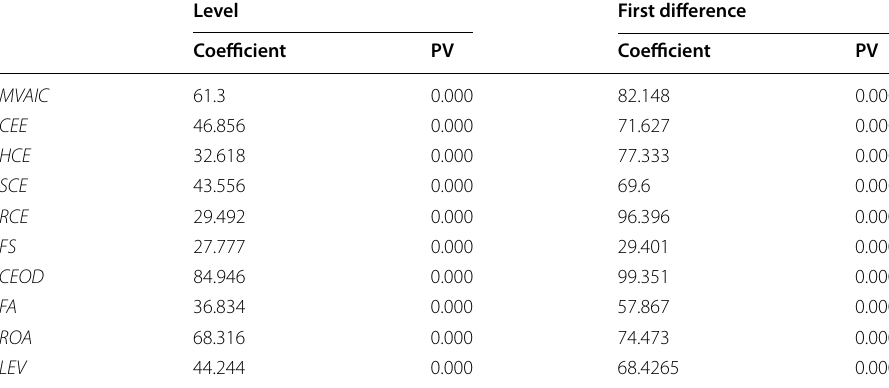
Table 3 ADF Unit